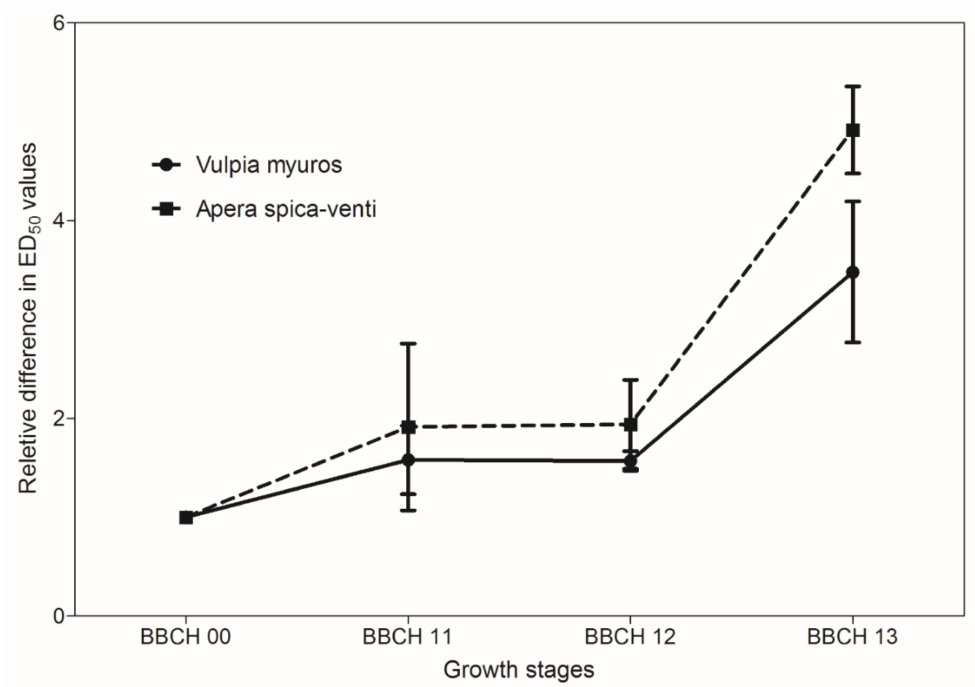
Figure 8. The relationship between relative difference in ED 50 values with the increased growth stages and BBCH growth stages in V. myuros and A. spica-venti . The ED 50 values with the increased growth stages were pooled across Experiments 1–3. Vertical bars represent standard errors of the